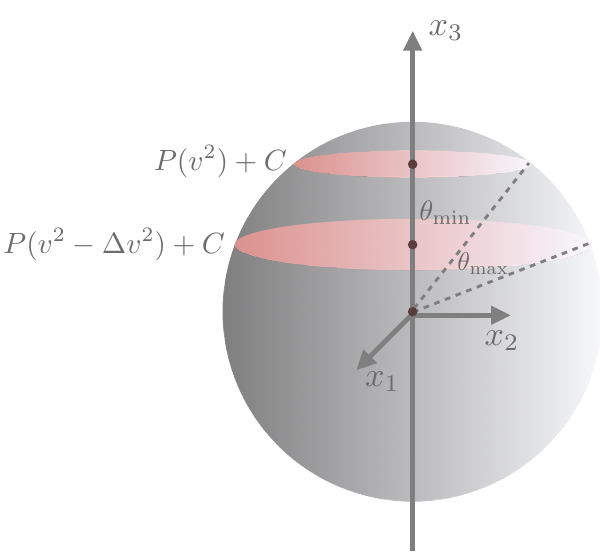
Figure 2 . Geometry of flux-space constraints for J = 3 . This very same configuration can be applied for larger J if one replaces x